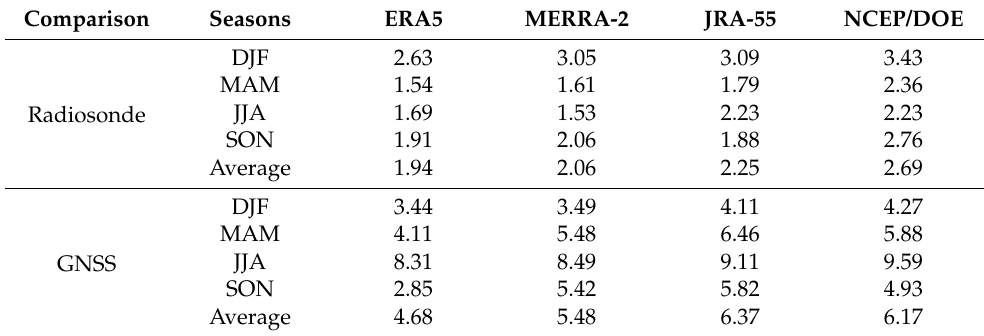
Table 6. Statistical results of the mean absolute differences in relative PWV trends (in % decade − 1 ) for the four seasons at the eleven radiosonde and seven GNSS stations over Antarctica. Comparison Seasons ERA5 MERRA-2 JRA-55 NCEP/DOE